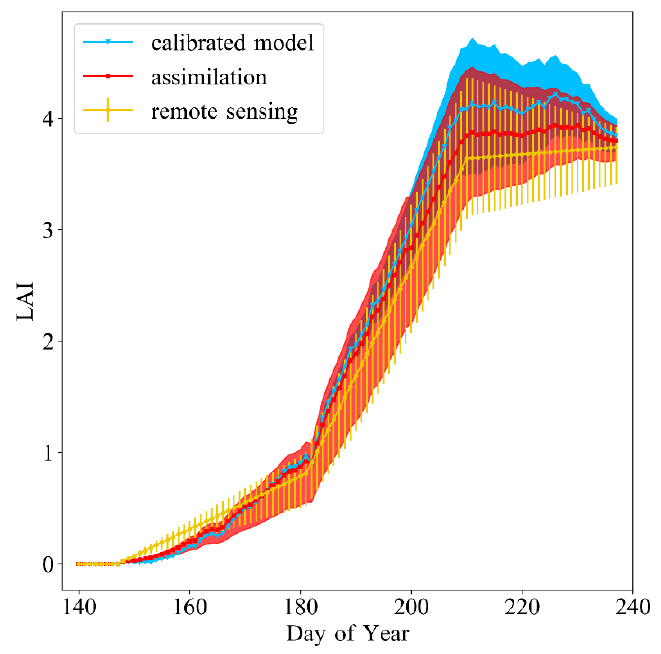
Figure 9. The seasonal LAI estimated using three methods: the calibrated WOFOST model, the assimilation method, and the VI-based empirical using RS data.